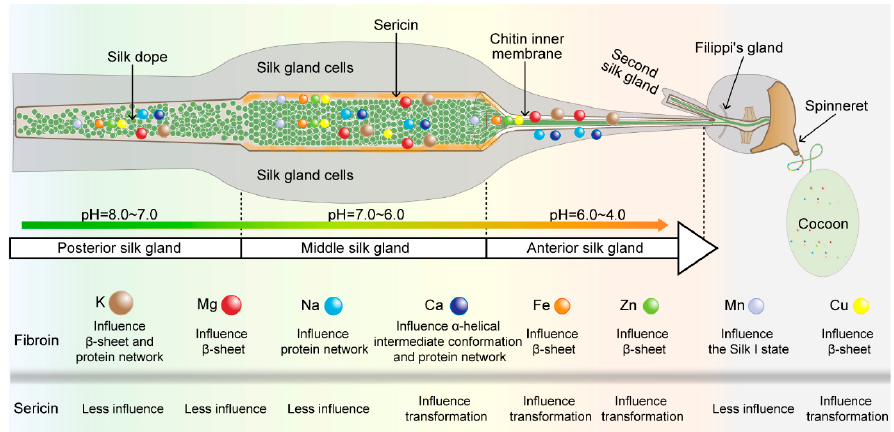
Figure 8. Overview diagram of metal ions and silk protein.